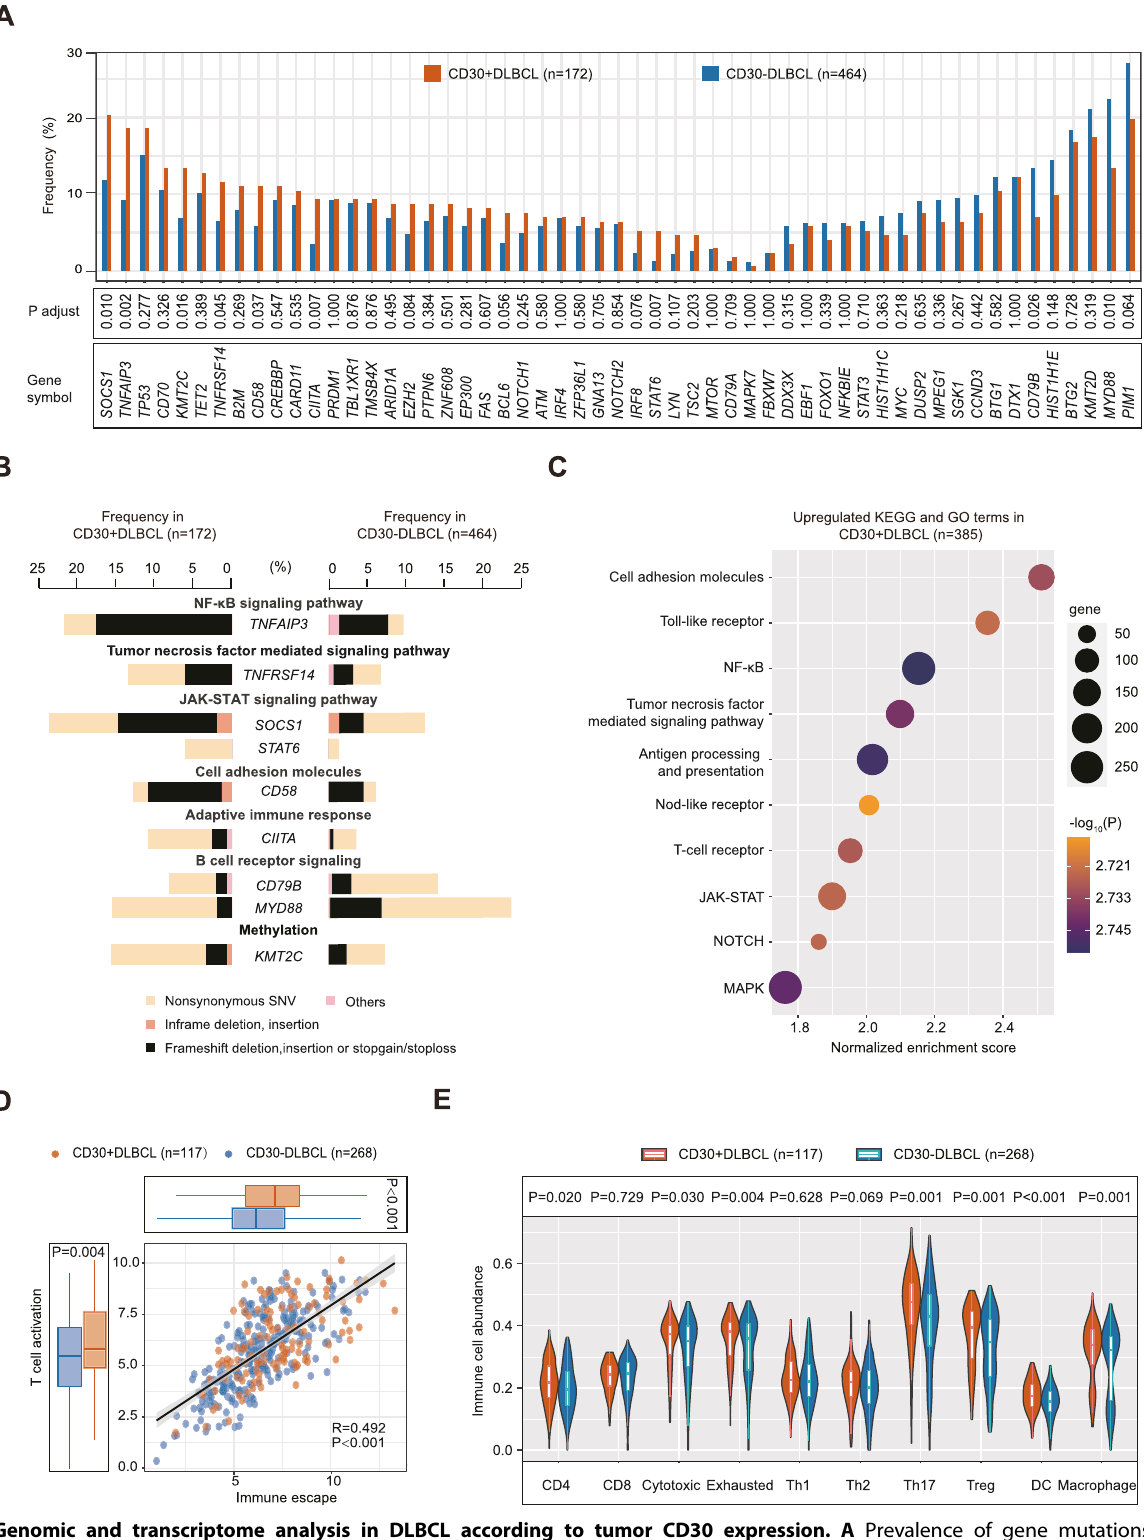
Fig. 1 Genomic and transcriptome analysis in DLBCL according to tumor CD30 expression. A Prevalence of gene mutations in 55 lymphoma-associated genes, along with the P value for the difference in prevalence between 172 CD30 + DLBCL and 464 CD30-DLBCL. B Prevalence and type of recurrent mutations and their function in CD30 + DLBCL. Mutation types are color-coded as indicated in the legend below. C Gene-Set Enrichment Analysis (GSEA) revealed pathway alterations in 117 CD30 + DLBCL and 268 CD30-DLBCL. GSEA preranked tool was used to analyze oncogenic and immune-associated pathways. D Left and upper panels indicate T-cell activation score and immune escape score, respectively, strati fi ed by 117 CD30 + DLBCL and 268 CD30-DLBCL. E In fi ltration score of indicated immune cells in tumor samples according to CD30